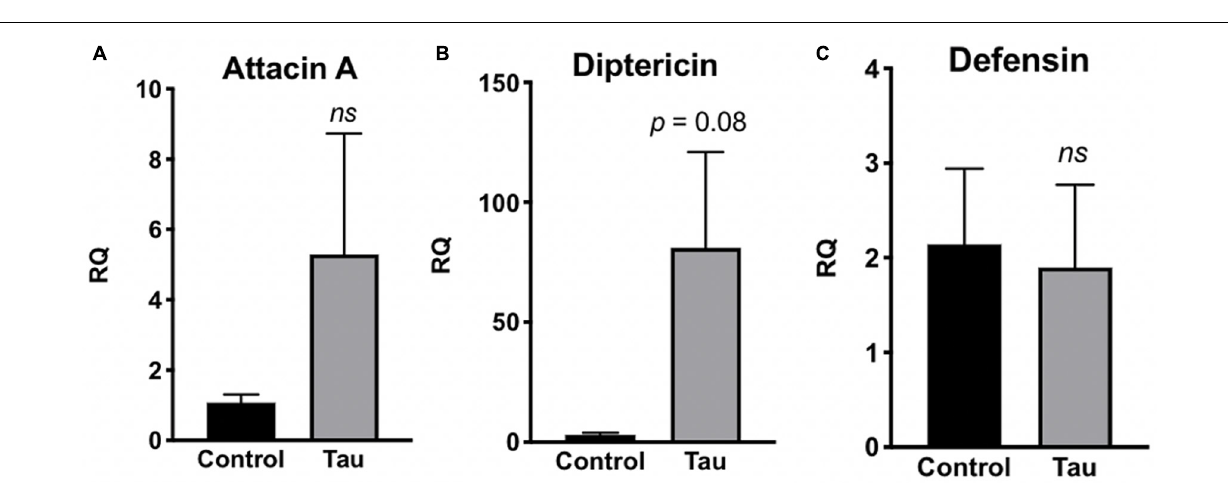
FIGURE 3 | Tau transgenic flies show trends of enhanced innate immune activation to gram-negative bacteria. qPCR targeting the antimicrobial peptide transcripts attacin-A (A) , diptericin (B) , and defensin (C) . RQ values suggest a non-significant elevation in innate immune expression of attacin-A and diptericin, but there is no trend observed in expression levels of the antimicrobial peptide transcript defensin. ( n = 6, p > 0.05). Data are shown as average ±